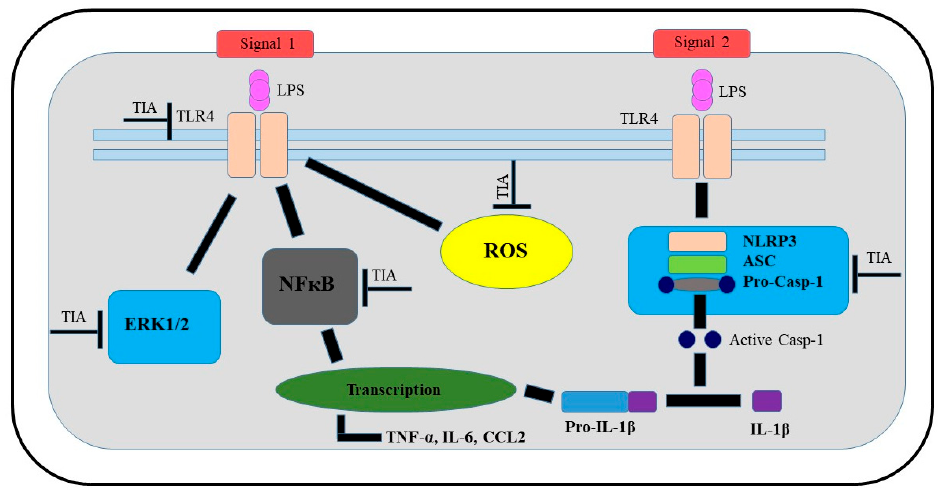
Figure 8. Schematic illustration of potential targets of beneficial tianeptine action in LPS-stimulated microglial cells. Abbreviations: TIA—tianeptine; LPS—lipopolysaccharide; TLR4—Toll-like receptor 4; NLRP3—the NOD-like receptor pyrin-containing 3 inflammasome; ASC—apoptosis-associated speck-like protein containing a caspase recruitment domain; ERK 1/2, extracellular signal-regulated kinases; NF- κ B—nuclear factor; IL—interleukin; casp—caspase; ROS—reactive oxygen species; TNF—tumor necrosis factor;